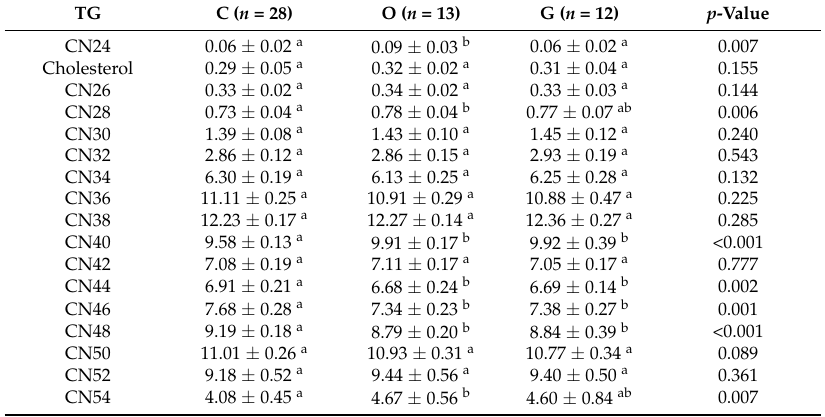
Table 2. Average triglyceride (TG) composition of conventional (C), organic (O), and grass (G) retail full-fat butters: mean concentration, standard deviation and significant differences between butter types